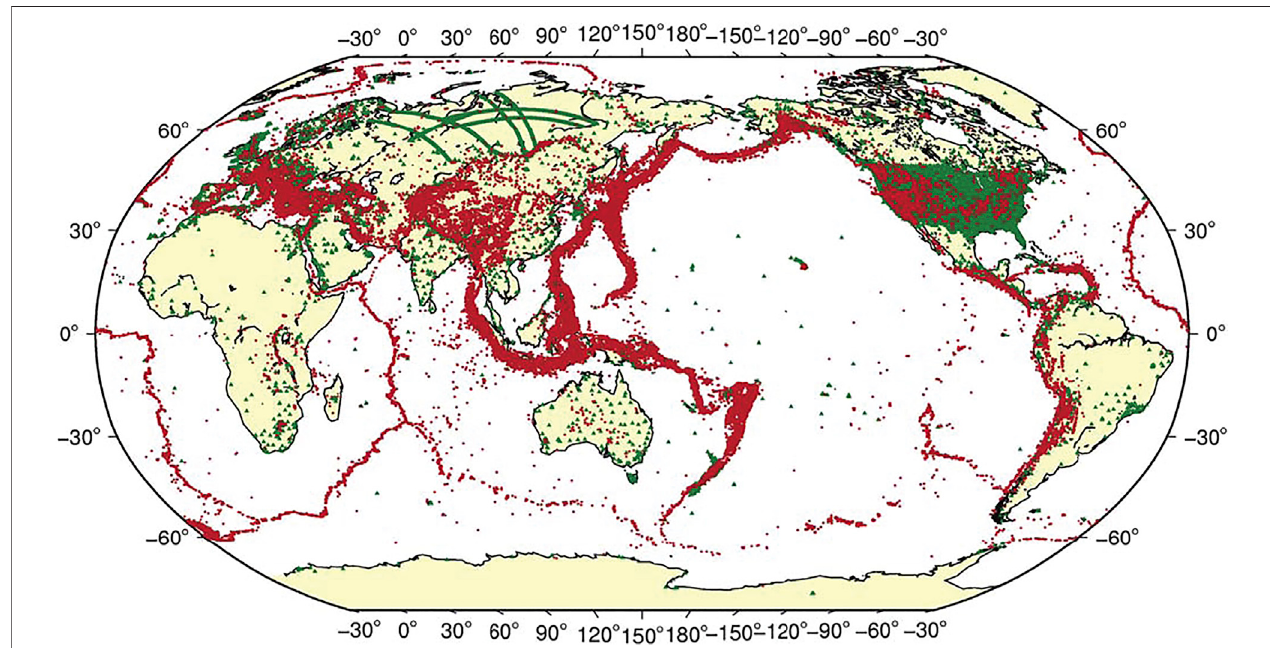
FIGURE 2 | Global seismic sources (red) and existing or previously existing seismic stations (green) showing heterogeneity of coverage, with particular absence of sources and receivers in the ocean basins.